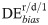
Illustrative antenna designs produced by the best run (based on HV) of ACO, DEbiasr/d/1 and DEbiasr/d/3*.The bottom row comprises antennas with lowest f0, the middle row those with f0 nearest 433 MHz and the top row those with f0 nearest 915 MHz. The location of each antenna is circled on the attainment surfaces (reproduced from Fig 7).